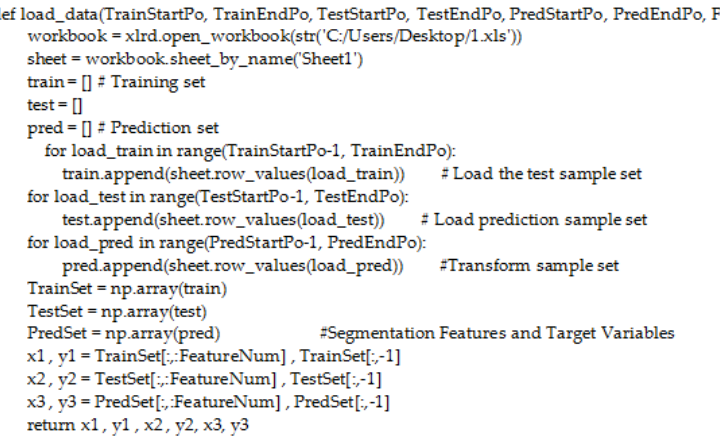
5 of 11 Table 3. Test sample data.